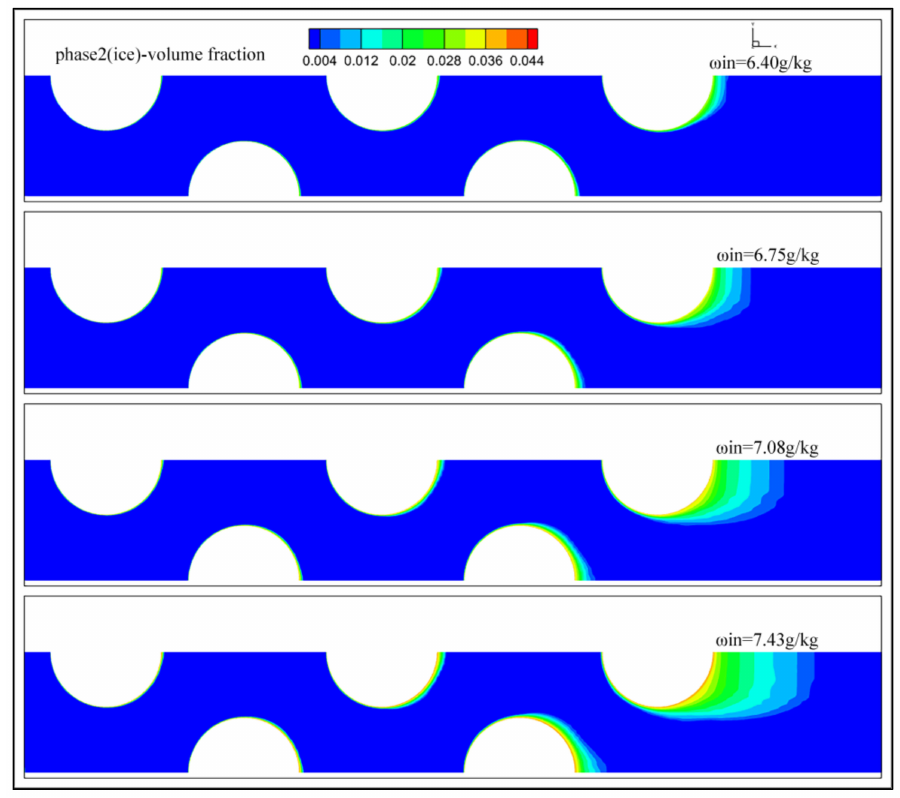
Figure 21. Frost morphology at different moisture contents (5th